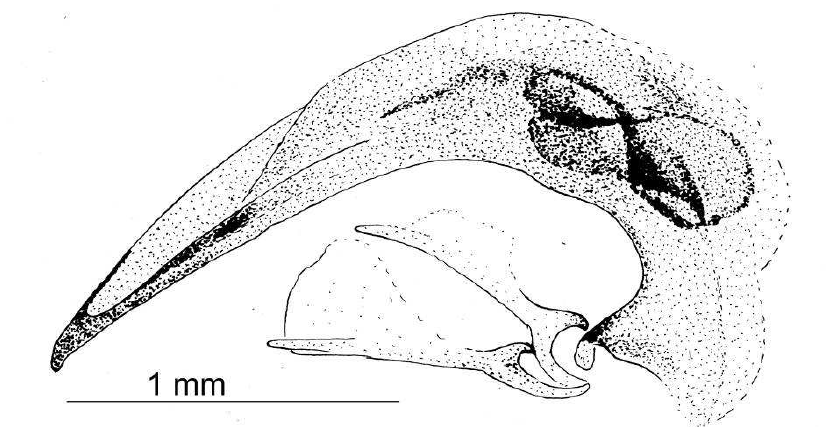
F IGURE 3. Deltomerus (Deltomerus) veldkampi sp. nov., holotype male; habitus, dorsal aspect. Scale: 5mm.